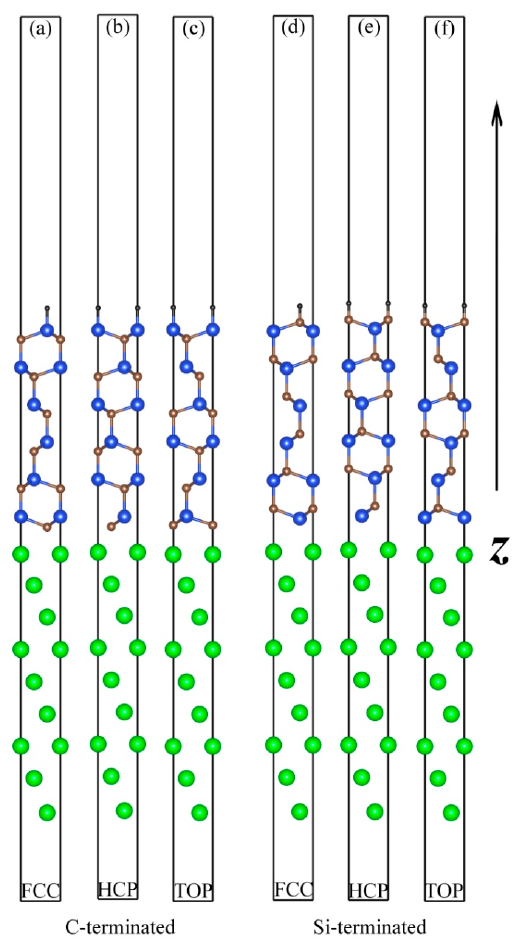
Figure 1. Side view of the Al (111)/6H-SiC (0001) interface: C-terminated and Si-terminated interface. There are three stacking sequences at the Al (111)/6H-SiC (0001) interface, namelythe FCC site ( a , d ), HCP site ( b , e ) and TOP site ( c , f ). Where the C (Si) atom at the interface is above the third Al atom